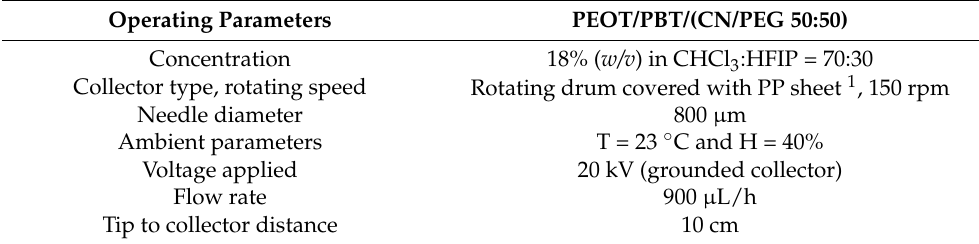
Table 1. Operating parameters for electrospinning PEOT/PBT and PEOT/PBT/(CN/PEG 50:50) (T = temperature, H =